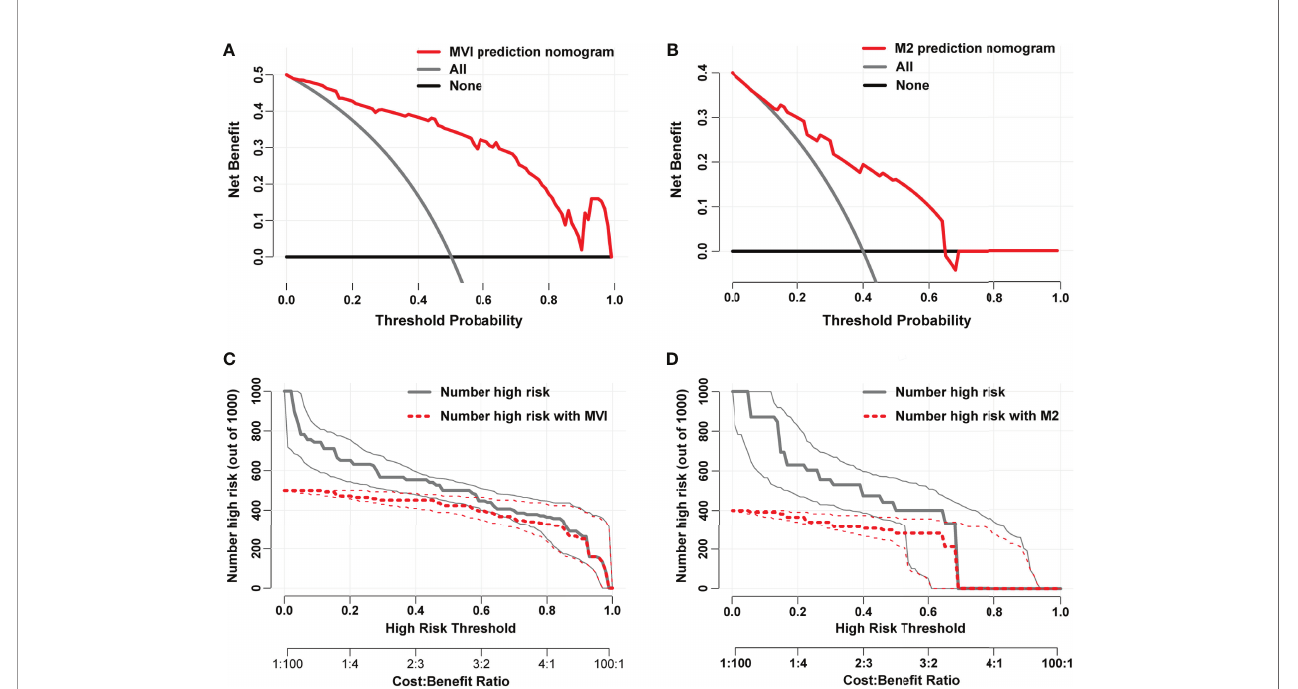
FIGURE 5 | Decision curves of the nomograms for predicting presence of MVI (A) and its M2 grade (B) . The horizontal solid black line represents the hypothesis that no patients experienced the presence of MVI or its M2 grade, and the solid gray line represents the hypothesis that all patients met the endpoint. Clinical impact curves of the nomograms for MVI and its M2 grade prediction, respectively, were plotted in (C, D) . At different threshold probabilities within a given population, the number of high-risk patients and the number of high-risk patients with the outcome were